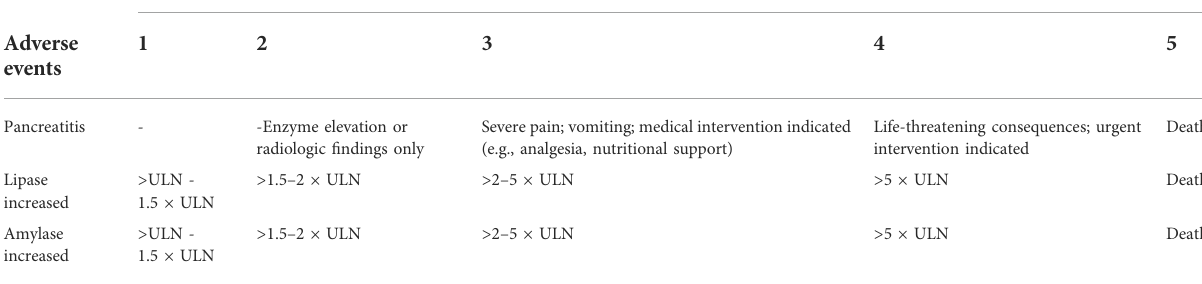
TABLE 1 CTCAE v5.0 classi fi cation criteria for pancreatic injury.